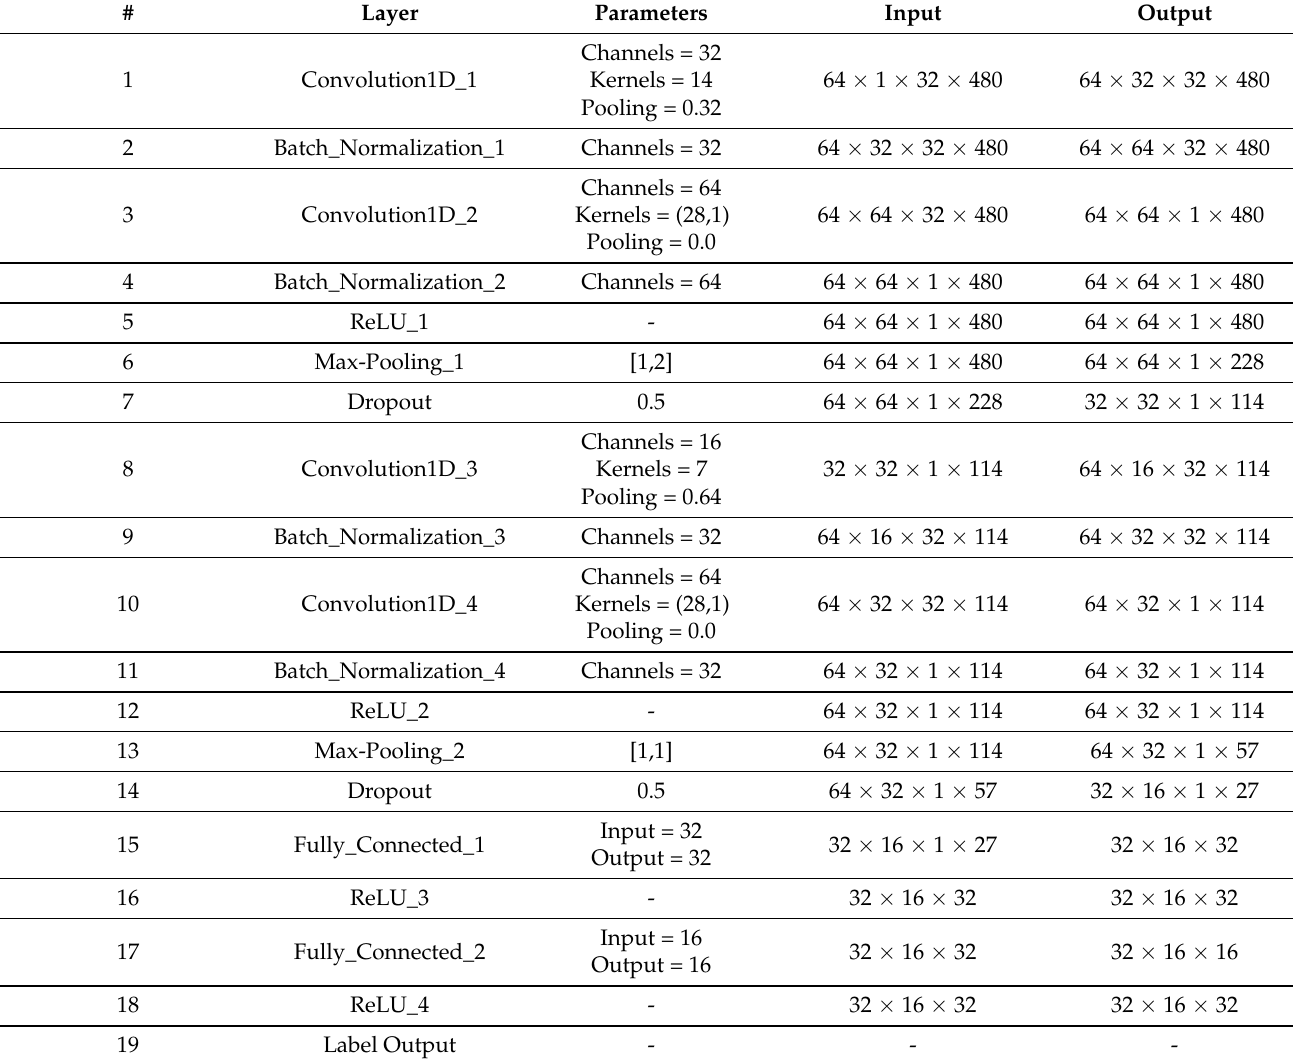
Table 1. Detailed information of proposed 1D CNN